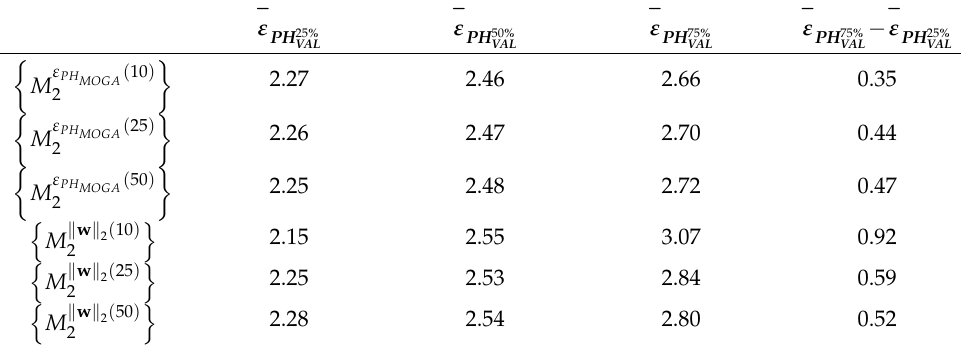
Table 7. Forecasting Performances for M 2.